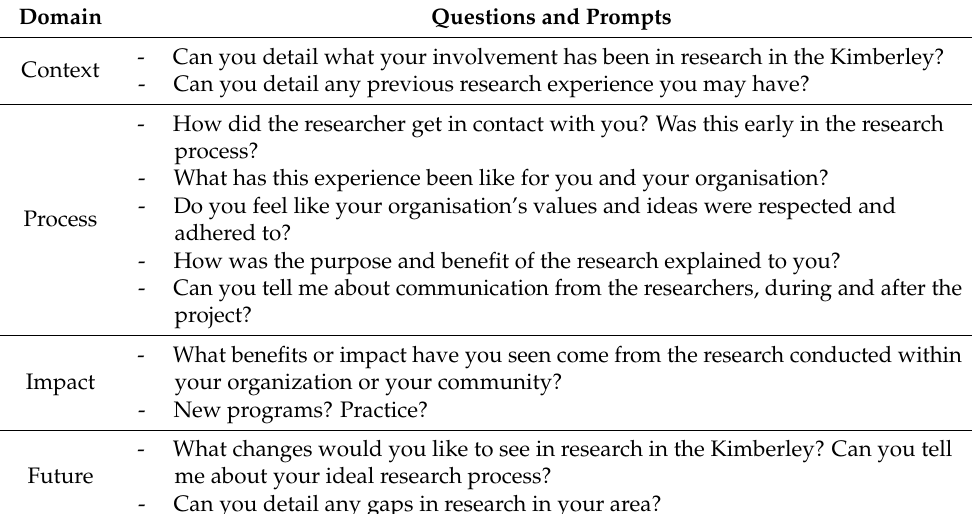
Table A1. Interview